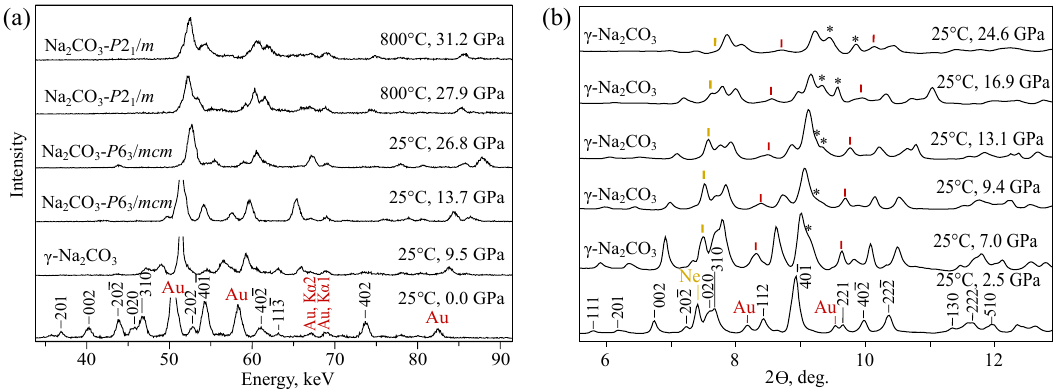
Figure 1. Diffraction patterns of Na 2 CO 3 obtained in MA ( a ) and DAC ( b )